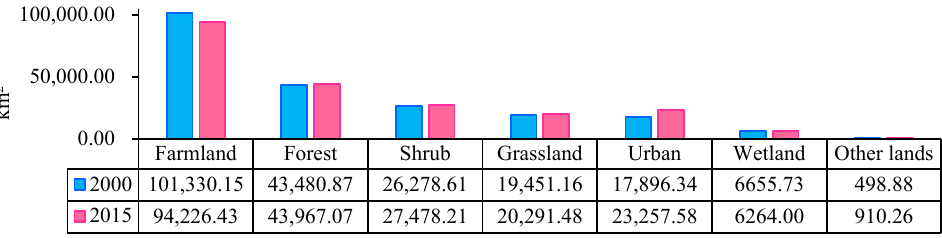
Figure 2. Areas of ecosystems in the Beijing–Tianjin–Hebei urban agglomeration in 2000 and 2015.